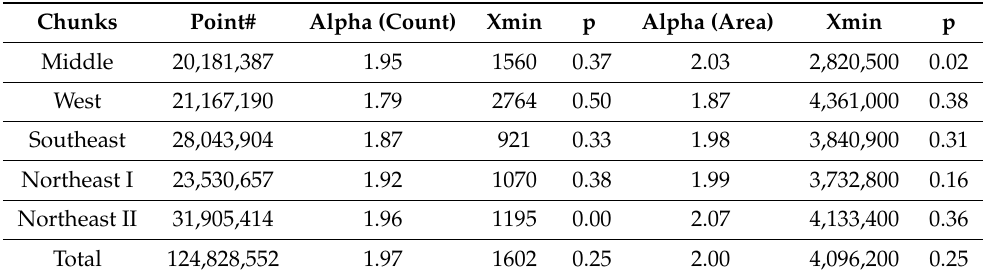
Table 4. Power law statistics of five parts of the US building.